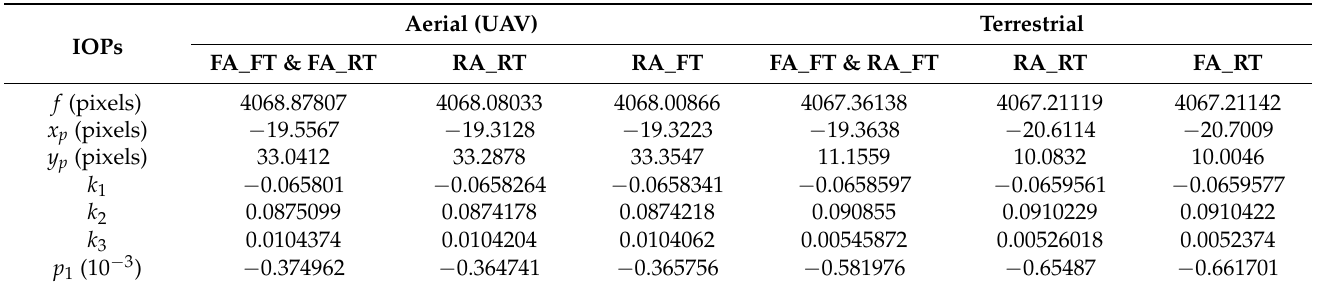
Table 3. IOPs of aerial (UAV) and terrestrial images after the BA of the Rathaus dataset using different SC strategies.